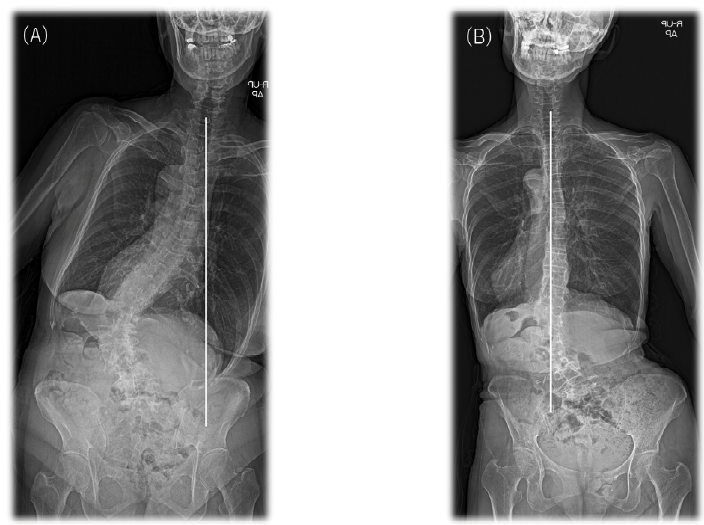
Figure 1. Two types of CM (type 1 and type 2) in patients with ASD classified according to the Obeid CM system. ( A ) An example of concave (type 1) and ( B ) convex (type 2) CM. CM, coronal malalignment.